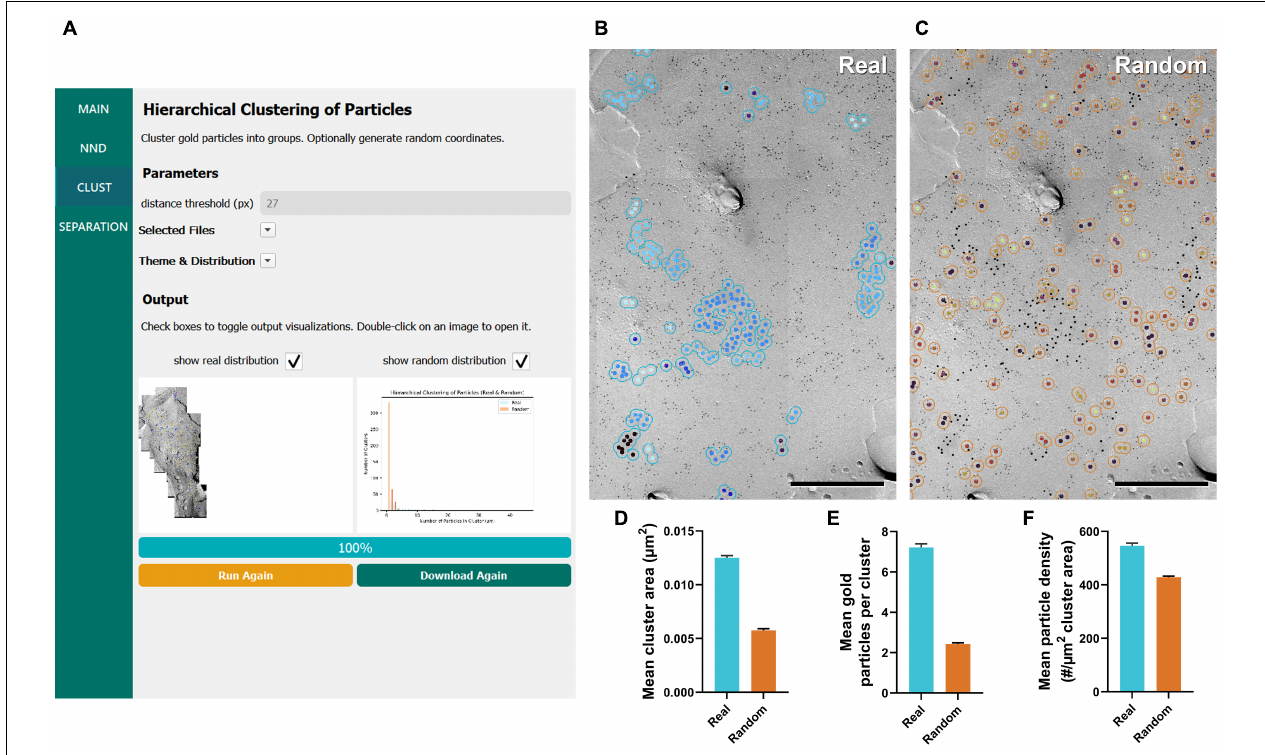
FIGURE 3 | GIO workflow result of gold particle hierarchical clustering analysis of Ca V 2.1 at the calyx of Held. (A) GIO interface showing the cluster analysis workflow. Parameters show additional fields for setting a distance threshold (in pixels). A labeled image of the ROI is displayed along with a histogram of the number of particles per cluster for real and/or random distributions. (B) The cluster analysis output for real particles, showing the same portion of ROI as in Figure 2B . (C) The cluster analysis output for randomly distributed particles superimposed on the same portion of ROI. (D) Grand mean area of clusters. (E) Grand mean number of gold particles per cluster. (F) Grand mean particle density within clusters. Error bars represent S.E.M. n = 6 ROIs. Scale bars: 500